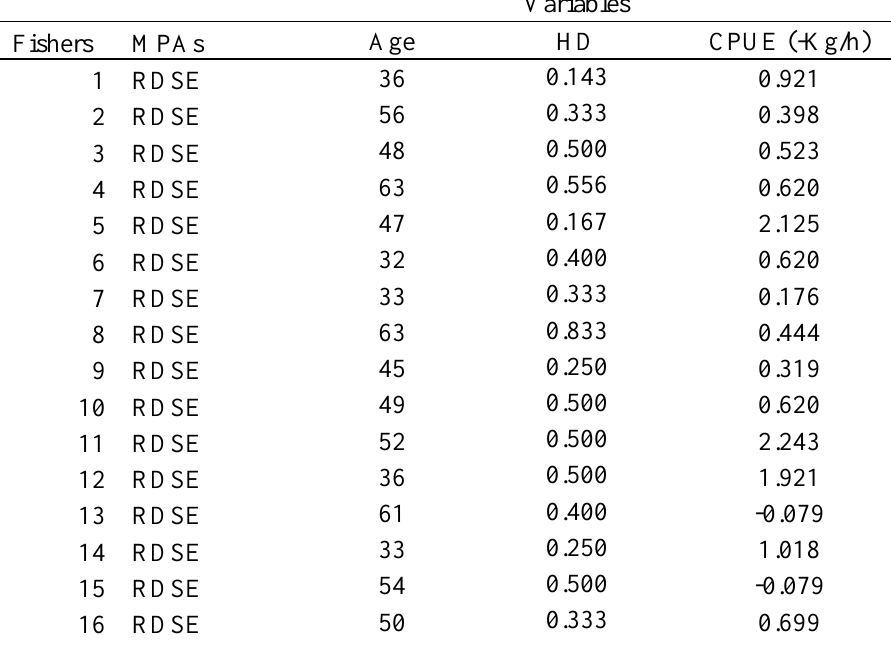
Table A5.1: Explanatory variables of the 100 fishers in the three reserves: Reserva de Desenvolvimento (RESEX Batoque, N=30), and Reserva Extrativista Prainha do Canto Verde (RESEX Canto Verde, N=30). HD = household economic dependence on fishing ; CPUE = Capture per unit of